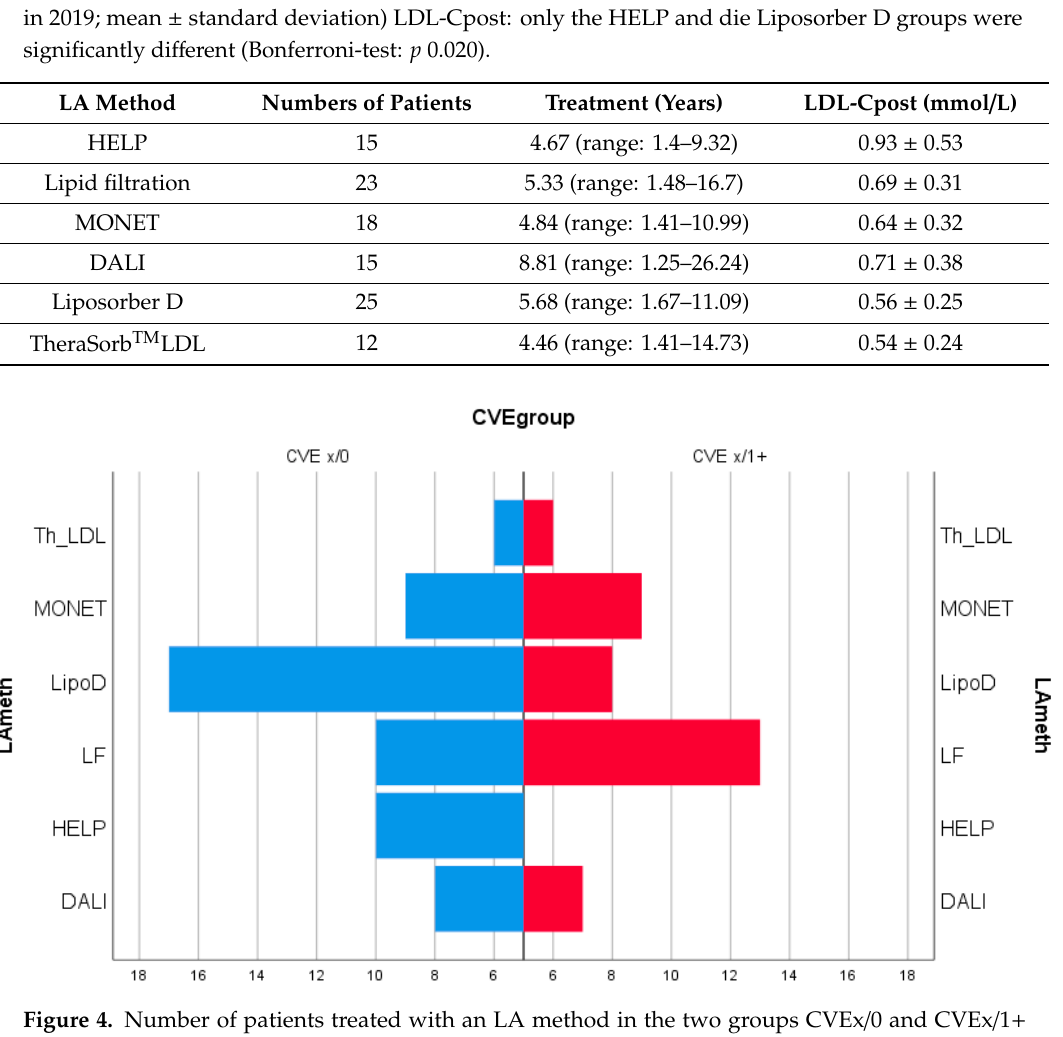
Figure 4. Number of patients treated with an LA method in the two groups CVEx/0 and CVEx/1+ (Abbreviations: Th_LDL TheraSorb TM LDL, LipoD Liposorber D, LF lipid filtration). (Abbreviations: Th_LDL TheraSorb TM LDL, LipoD Liposorber D, LF lipid